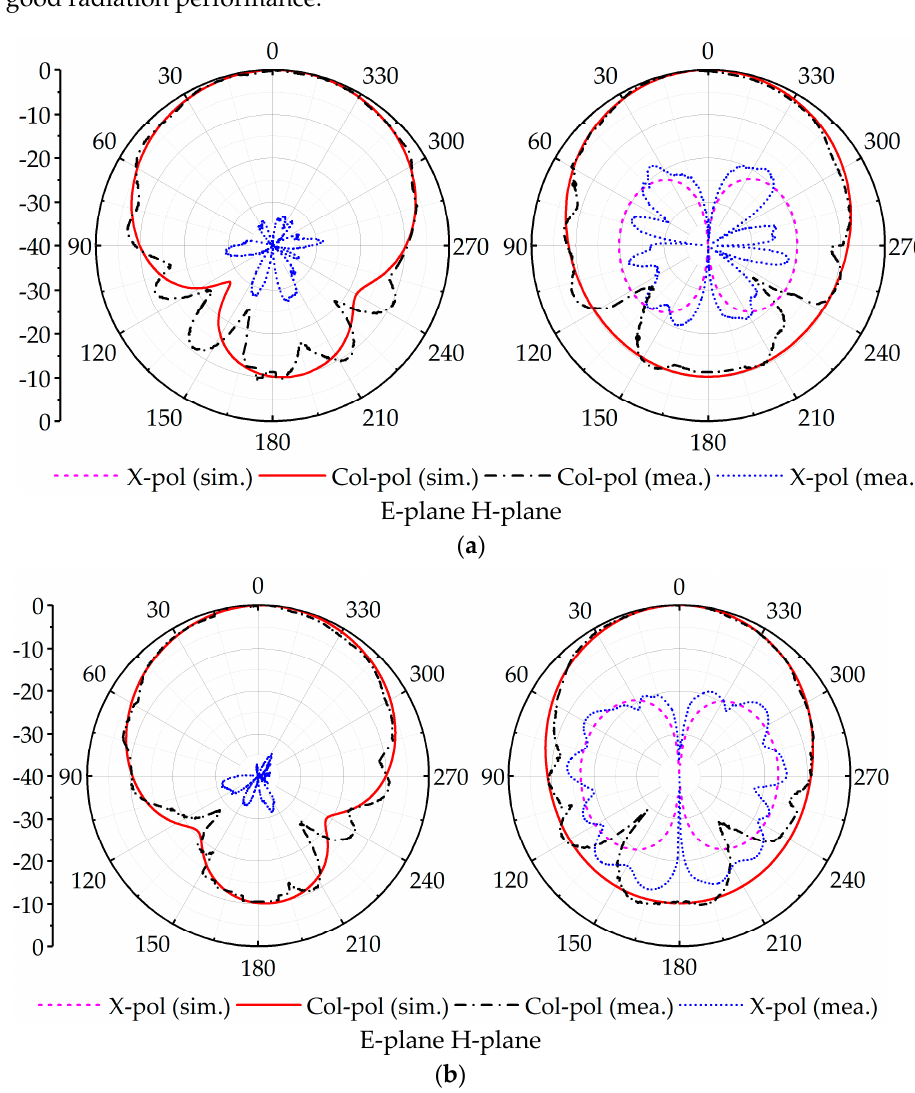
Figure 9. The simulated and measured radiation patterns: ( a ) 3.2 GHz; ( b ) 3.6 GHz.